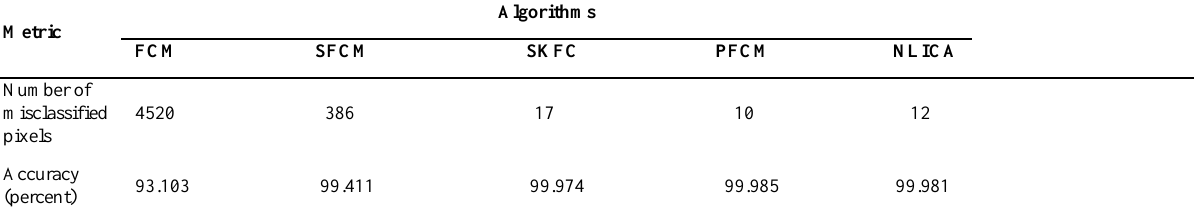
Table 1. Segmentation results of image number 1.